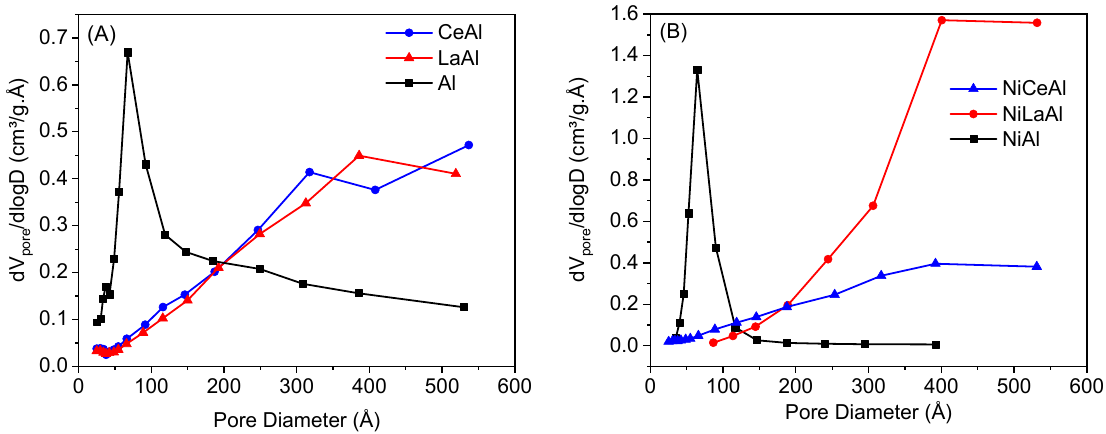
Figure 1. Pore size distribution for supports ( A ) and catalysts ( B ) determined by N 2 physisorption.